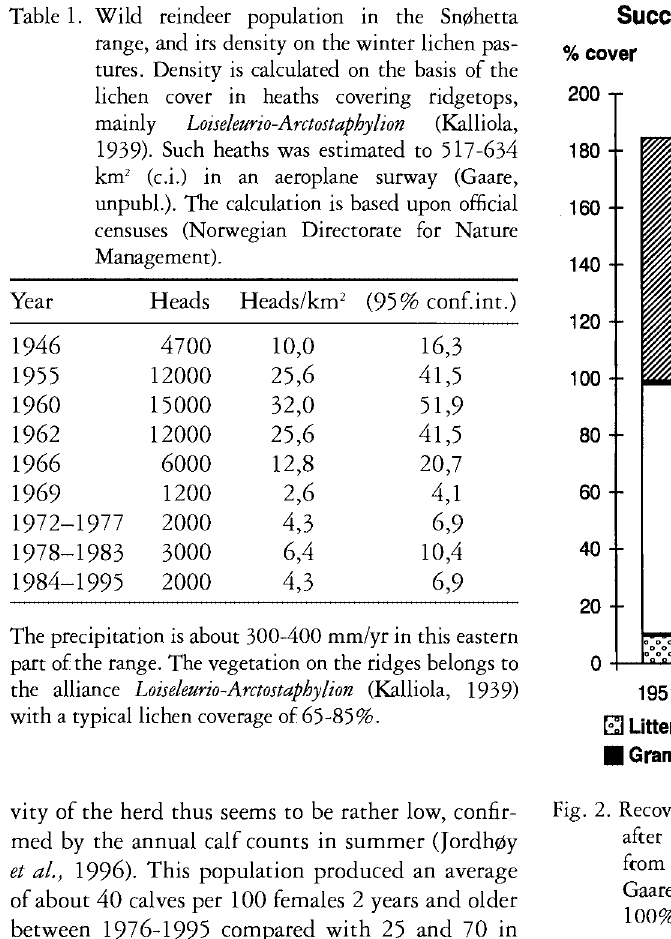
Fig. 2. Recovery of winter pastures in the Snøhetta range after the population high in the 1950's. Data from Nordhagen (1963) for 1951 and 1957 and Gaare (unpubl.) for 1963-1987. The more than 100% coverage in Nordhagens data is in part due to a transformarion from Hulr-Sernander scale ro percent coverage. Fig. 2 represents changes in cover from a repre sentative stand near Nordhagen. W h en heavy gra zing depleted the lichen cover from 75 to 2%, wind and water erosion removed much of the humus